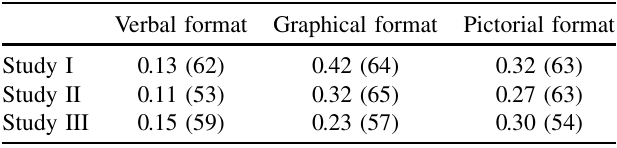
TABLE IV. Fraction of students choosing the linear alternative in the different representational